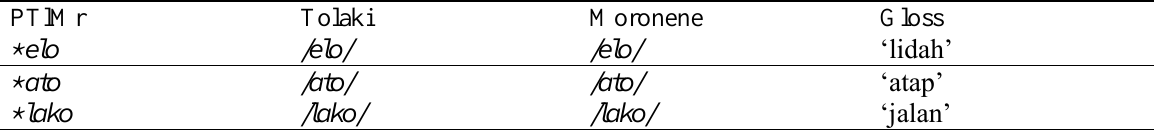
Table 16. The Final Word Position